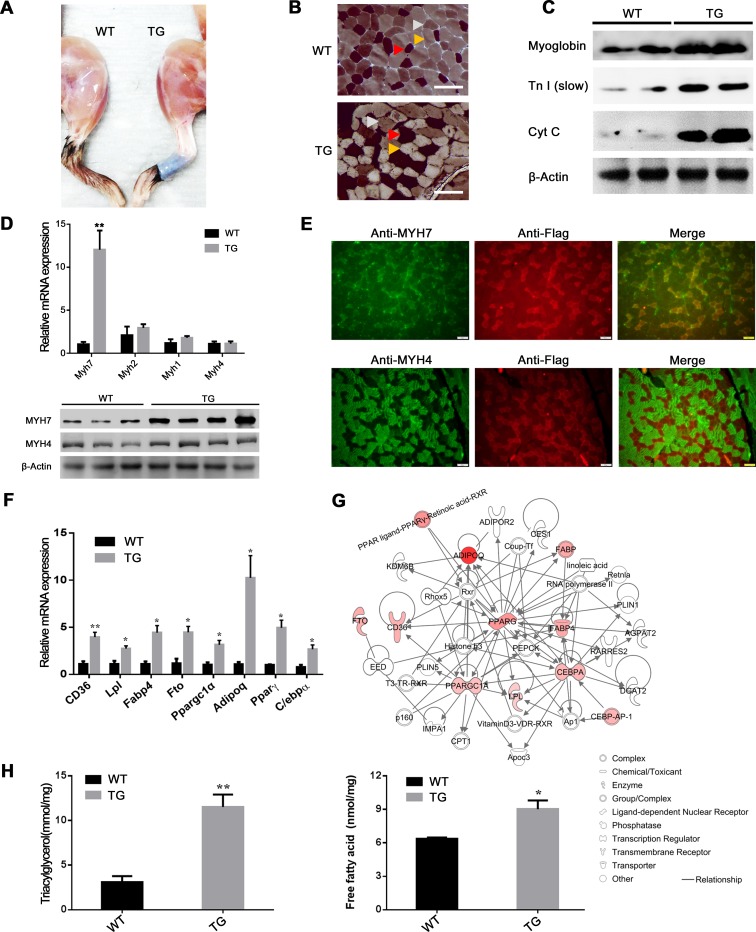
Characterization of MYH3 TG mice for muscle fiber type specification and adipogenesis.(A) Gross morphology of hindlimb muscle of WT and TG mice. (B) Hindlimb muscle stained for myosin ATPase histochemistry. Red arrowheads indicate type1 (slow/oxidative) fiber; yellow arrowheads indicate type2A (fast/oxido-glycolytic); and gray arrowheads indicate type2B (fast/glycolytic). Scale bar = 50 μm. (C) Western blotting assays of slow-type muscle associated proteins extracted from quadriceps muscles. We used a muscle sample from one animal per lane. (D) Gene expression analyses of muscle fiber type-associated genes by qRT-PCR (upper) and Western blot (lower). Data are from four-months-old WT (n = 3) and TG (n = 5) mice. (E) Immunohistochemical analysis using anti-MYH4 and anti-MYH7 antibodies in TG mice. Scale bar = 50 μm. (F) Expression of eight adipogenesis-associated genes in quadriceps muscle by qRT-PCR. Data are from mRNA prepared from four-month-old WT (n = 3) and TG (n = 5) mice. Data are presented as the mean±standard error. *P<0.05, **P<0.01. (G) The gene interaction network for adipogenesis generated by the ingenuity pathway analysis (IPA). Overexpressed genes are labeled in a reddish color. The color concentration represents the fold change of the genes (e.g., Adipoq shows the highest fold change). (H) Measurement of triacylglycerol and free fatty acids in quadriceps muscle. Data are from four-month-old WT (n = 3) and TG (n = 5) mice. *P<0.05, **P<0.01.